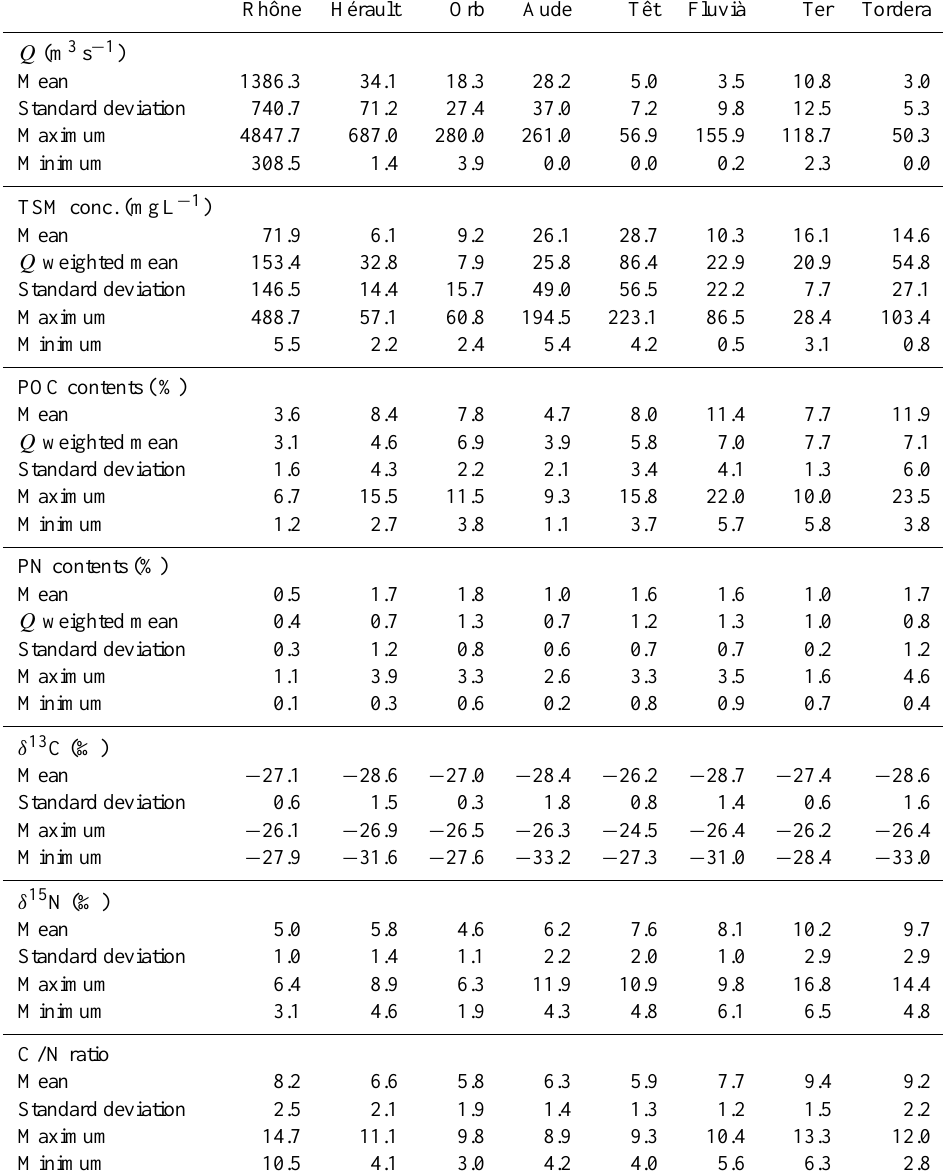
Table 2. Water discharge ( Q ), total suspended matter (TSM), suspended POC and PN contents, their stable isotopes ( δ 13 C and δ 15 N) and atomic C/N ratios are the biogeochemical parameters measured in all studied rivers from November 2008 to December 2009. The Q data are extracted from different data bases: Compagnie Nationale du Rhône (Rhône), Banque Hydro France (Hérault, Orb, Aude and Têt) and Agència Catalana deL’Aigua (Fluvià, Ter and